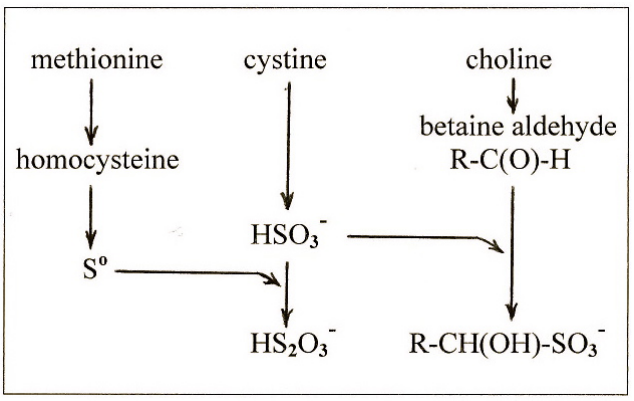
Table 8. Interpretation of the Effects of Sulfur Amino Acids and Choline on Fatty